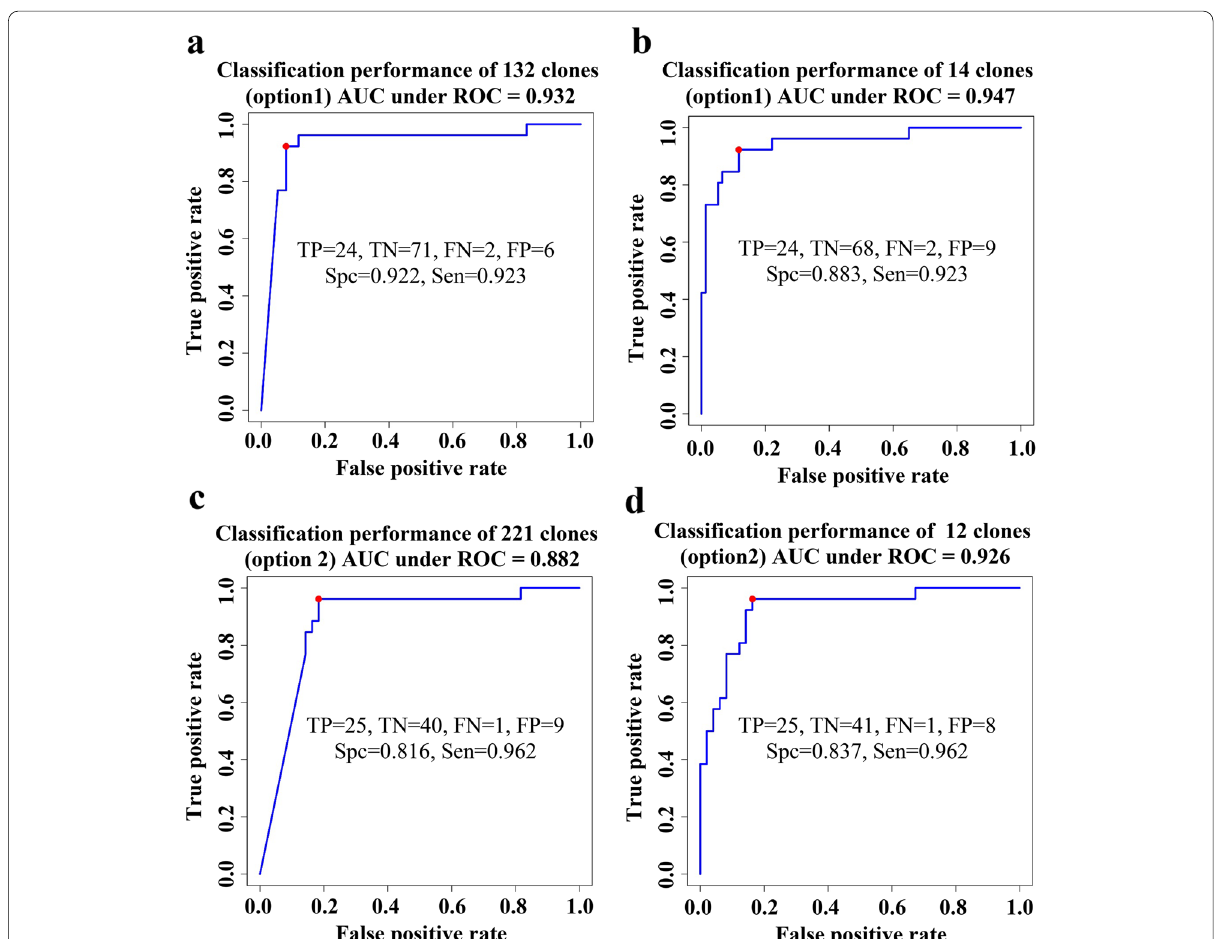
Fig. 6 Classification to predict sarcoidosis from healthy controls, TB patients and LC patients on the testing set. a Performance of 132 clones on the testing set (option1). b Performance of the top 14 classifier clones on the test set (option1). The ROC curves demonstrate excellent classification performance with AUC of 0.947 with a sensitivity of 0.883 and specificity of 0.923. c Performance of 221 clones at the FDR testing set. d Performance of the top 12 classifier clones (option 2) on the test set. The ROC curves demonstrate strong classification performance with AUC of 0.926 with sensitivity of 0.962 and specificity of